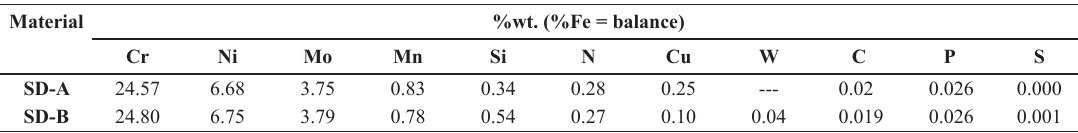
Table 2. Percentages of phases and grain sizes in materials SDA and SDB as received.